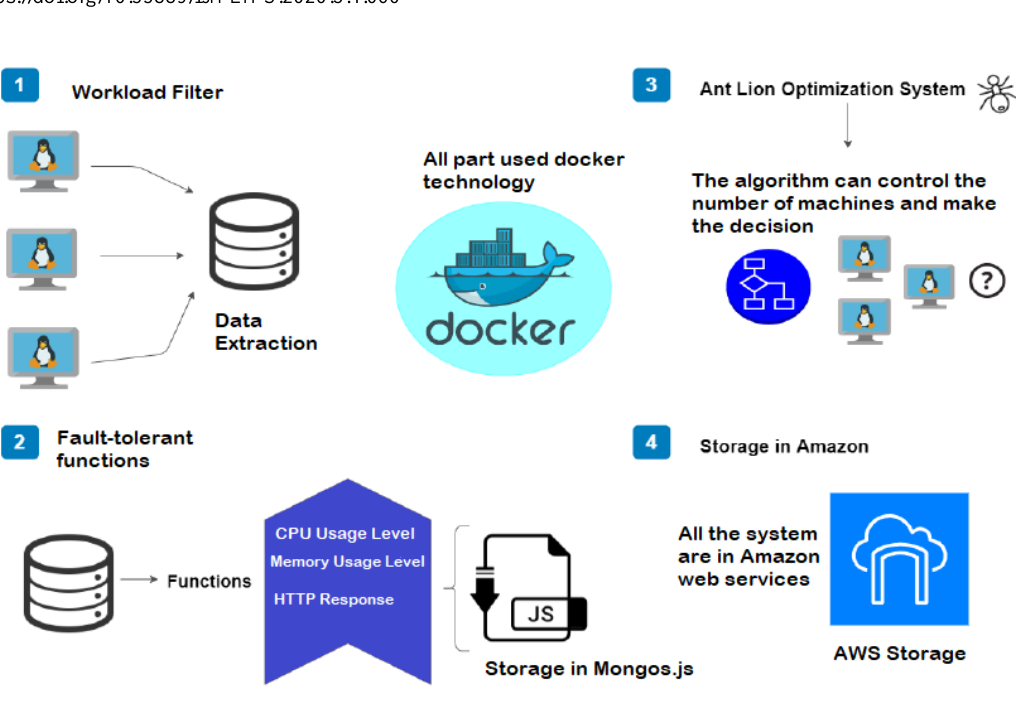
Figure 1. Architecture of Proposes ALO based